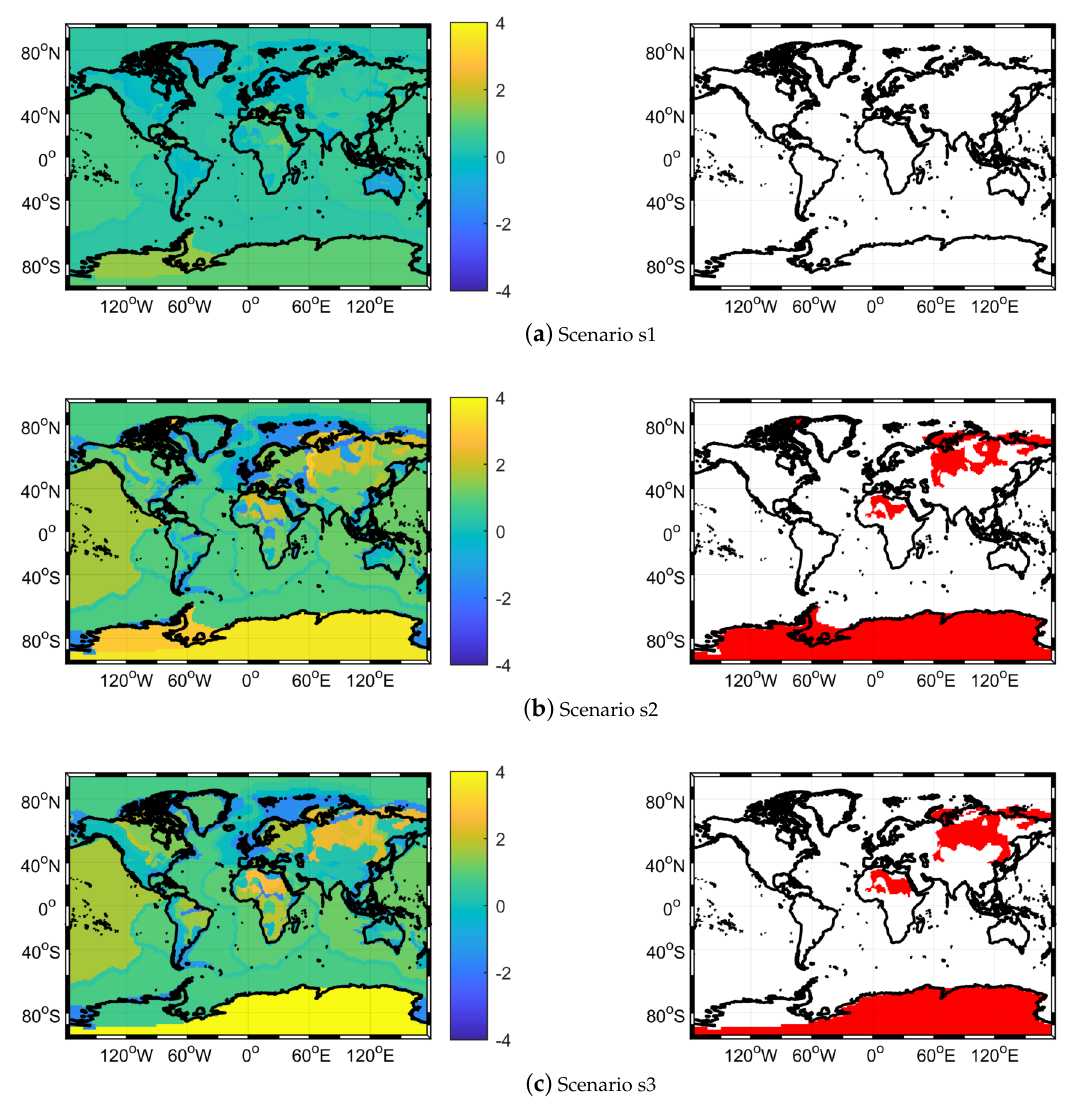
Figure 15. Results of test 4. For each scenario, the empirical value of the statistics on the left, and in red the geological provinces for which the consistency hypothesis is rejected on the